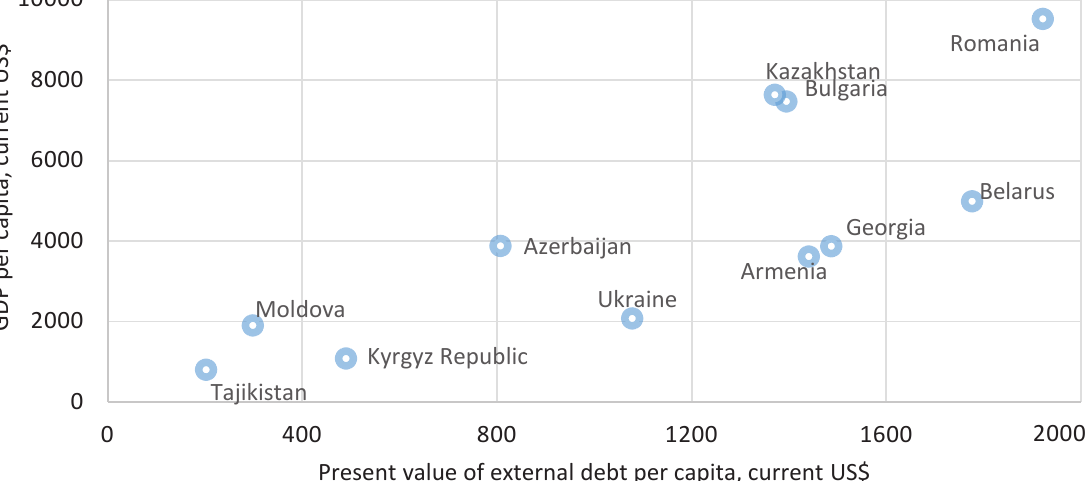
Figure 3. Matrix of correlation of present value of external debt per capita and GDP per capita in emerging economies, 2016